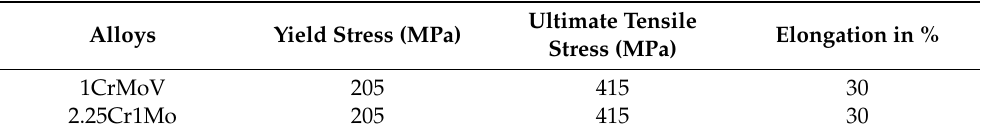
Table 3. Mechanical features of low alloy steels (grade 11 & 22), reprinted with permission from ref. [41]. Copyright 2007 Elsevier B.V.